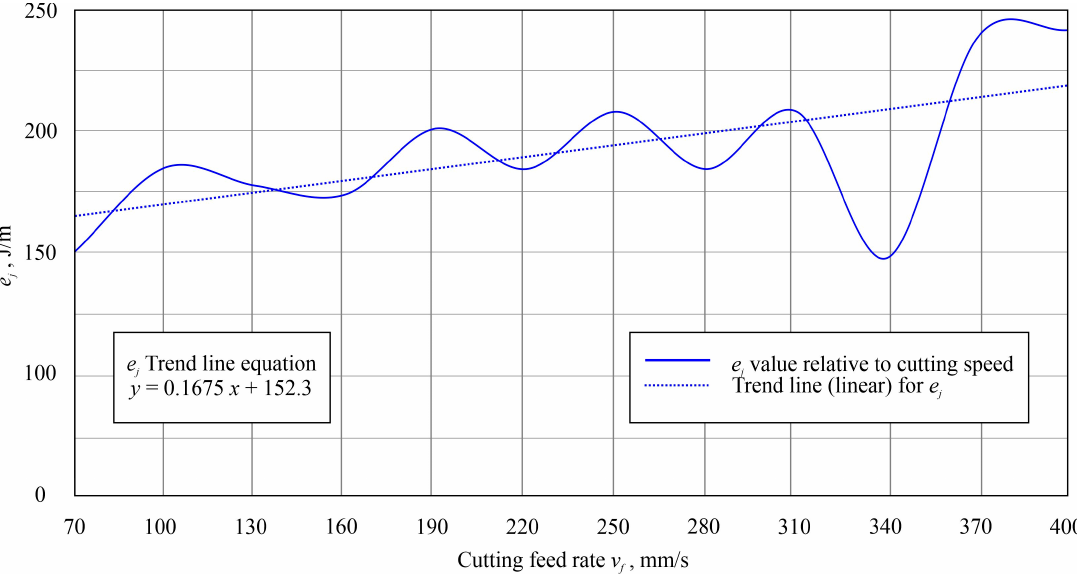
Figure 8. Graph for unit energy intensity of the cutting process e j relative to cutting speed v f